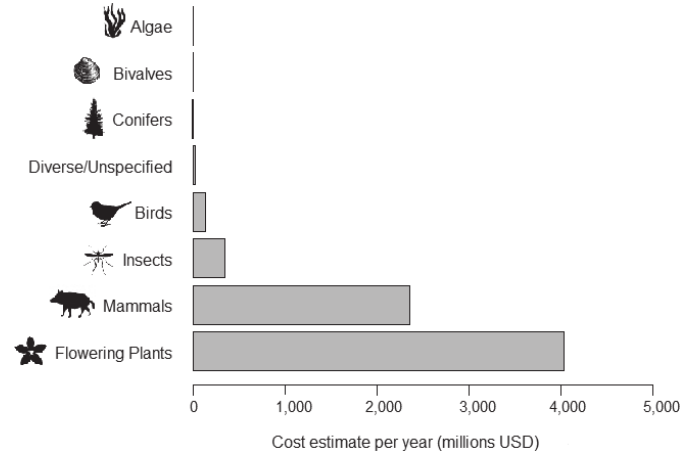
Figure 3. Economic costs of IAS in Argentina by taxonomic groups